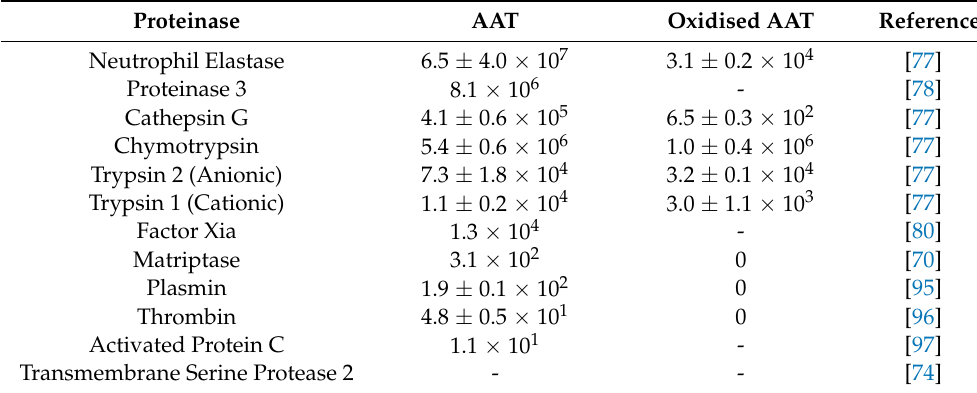
Figure 4. Alpha-1 antitrypsin elastase complex. Model based on the crystal structure of alpha-1 antitrypsin complexed with porcine pancreatic elastase (pdb code 2D26) and the crystal structure of human neutrophil elastase (pdb code 3Q76). Table 3. Known serine proteases that bind and are inhibited by alpha-1 antitrypsin.